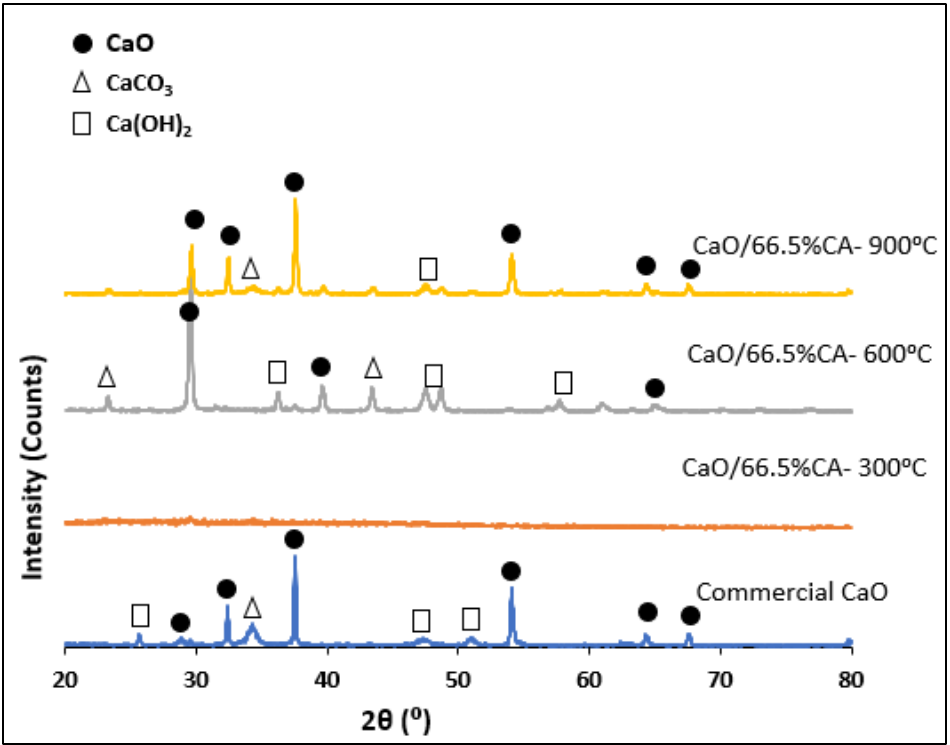
Figure 4. RXD pattern of CaO/CA and commercial CaO catalysts.